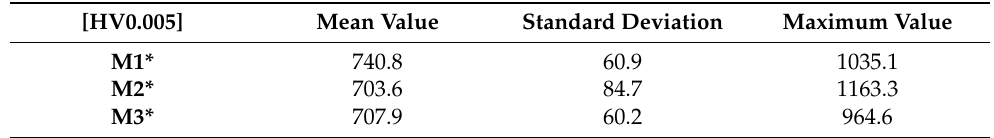
Figure 11. Micro hardness surfaces of M1*, M2* and M3*. Table 7. Results of the micro hardness tests.